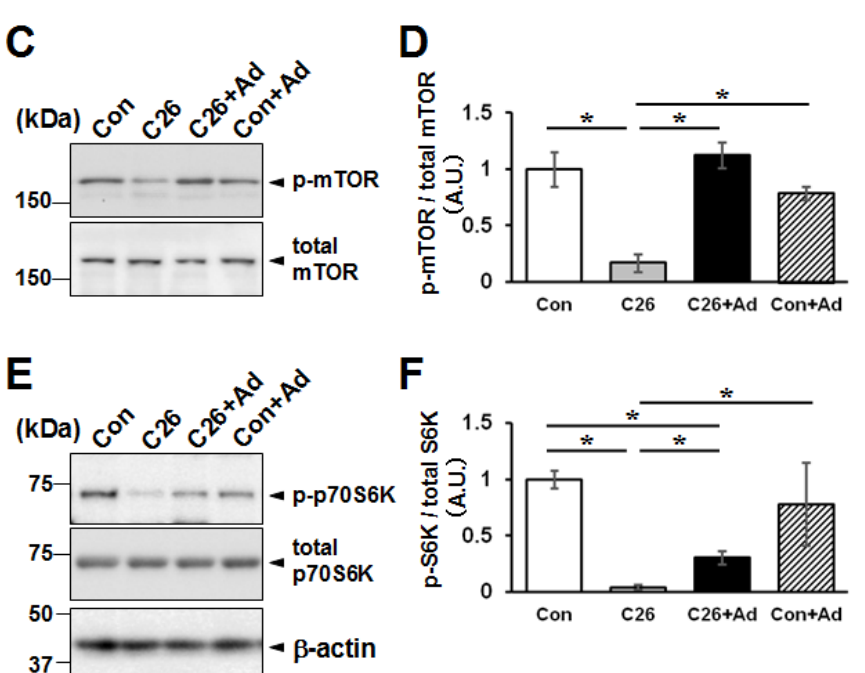
Figure 7. Effects of adiponectin treatment on the protein synthesis pathways in the in vitro cancer cachexia model. C2C12 myotubes were treated with C26 derived conditioned medium (C26-CM) or 1 µg/mL adiponectin, as indicated in Figure 6. Total proteins were analyzed by western blotting using antibodies for phospho-Akt and pan-Akt ( A ), phospho-mTOR and pan-mTOR ( C ), and phospho- and pan-p70S6 kinase (S6K) ( E ). A representative result from one of three independent experiments is shown. Densitometric analyses of western blotting shown in ( A , C , E ) are presented in ( B , D , F ) respectively. The bar graphs indicate the mean relative expression ± SD. Statistical analysis was performed by Kruskal-Wallis analysis followed by Mann-Whitney U tests. *: p < 0.05.